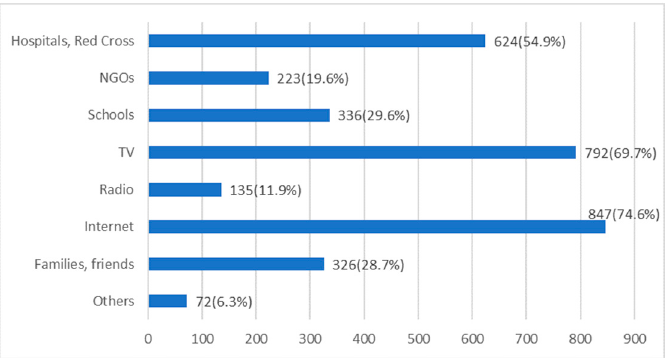
Figure 1. Ways to acquire knowledge and skills towards public